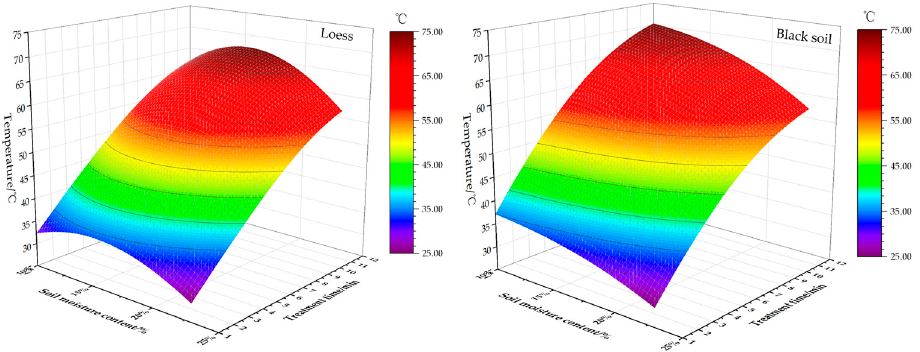
Figure 32. Fitting surface of the internal temperature of the soil irradiation area with the time of irradiation and soil moisture content (“irradiation time–soil moisture content” temperature surface). Table 5. Irradiation time–soil moisture content temperature surface equation.